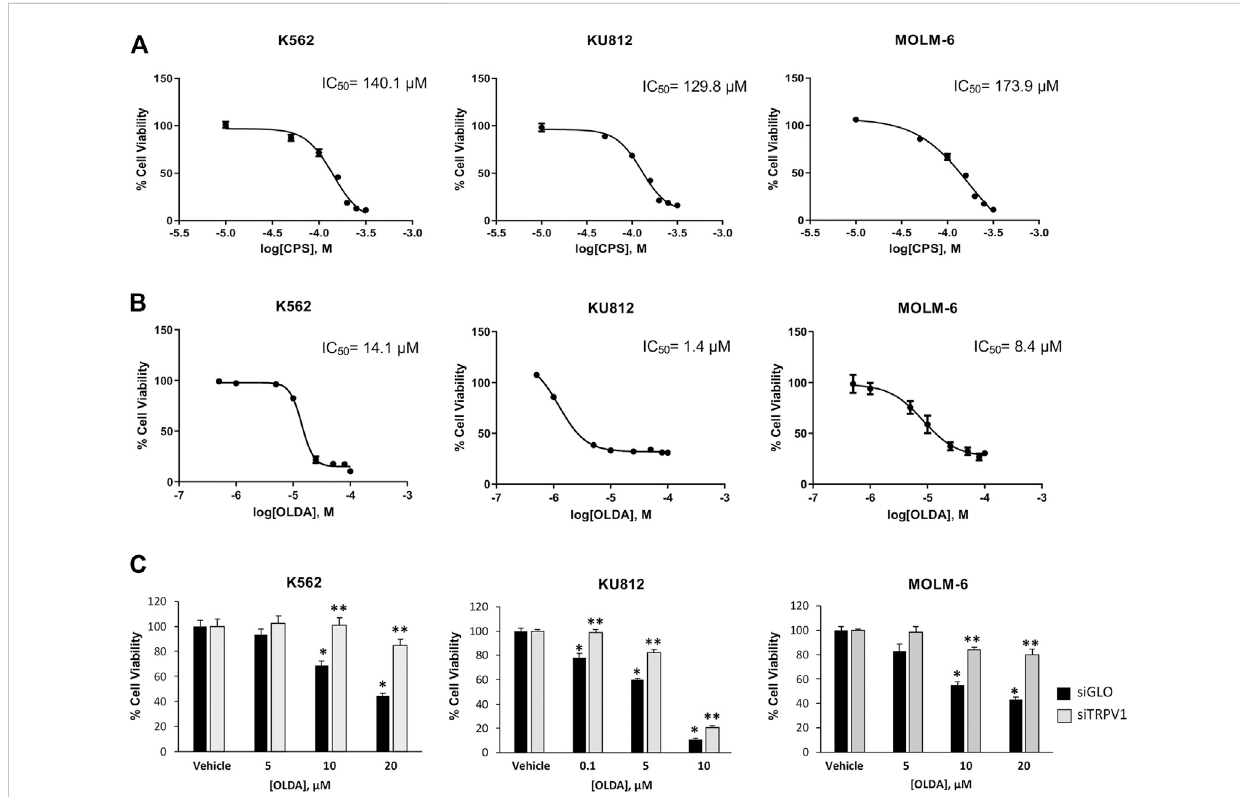
FIGURE 1 OLDA, the agonist of TRPV1, inhibits cell growth in CML cells. (A) Cell viability of CML cells treated for 24 h with different doses of CPS. Data are the mean ± SD for three experiments. (B) Cell viability of CML cells treated for 24 h with different doses of OLDA. Data are the mean ± SD of three experiments. (C) Cell viability was assessed in siTRPV1 and siGLO cells treated for 24 h with different doses of OLDA in the range of IC 50 or the vehicle. Data are the mean ± SD of three experiments. * p < 0.05 vs the vehicle; ** p < 0.01 vs OLDA-treated siGLO